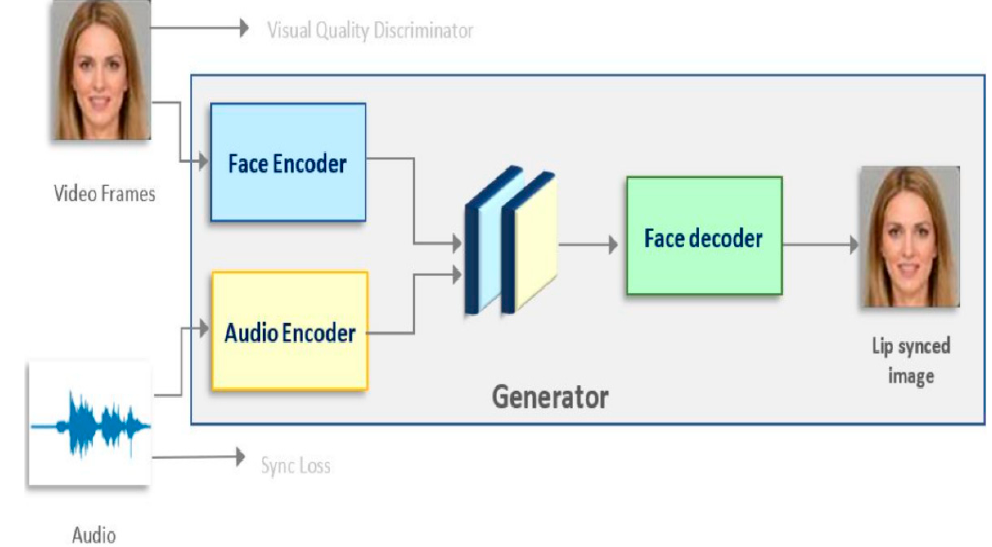
Figure 2. Proposed data-augmentation architecture using GANs for AVSR in the